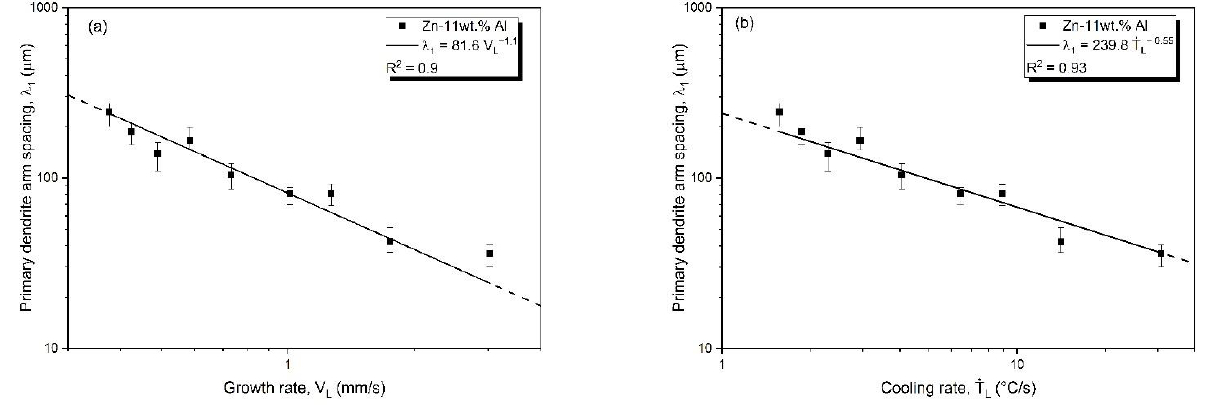
Figure 16. Primary dendritic arm spacing as a function of solidification thermal parameters of the Zn-11wt.%Al alloy: ( a ) growth rate and ( b ) cooling rate.